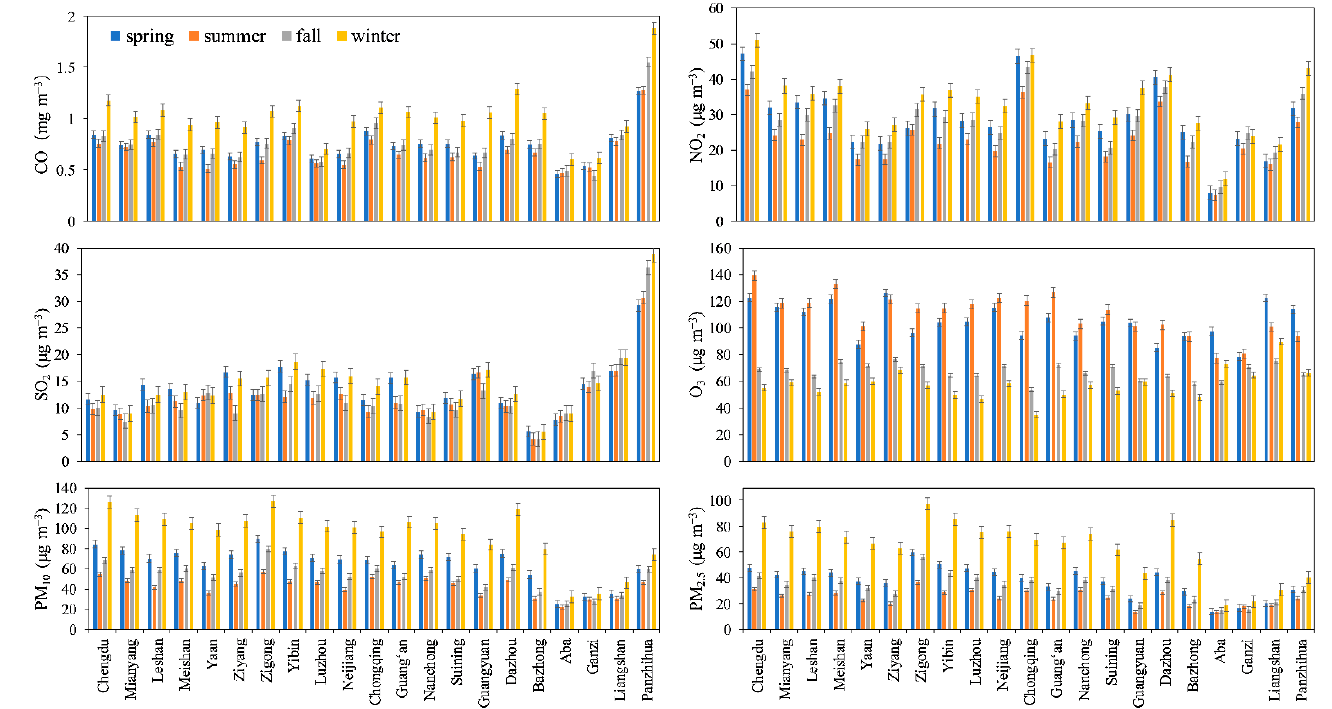
Figure 4. Seasonal variation in concentrations of air pollutants in Sichuan Basin. The vertical error bars represent the standard deviation values. Spring (March to March), Summer (June to August), Autumn (September to November), Winter (December to February of the following year).